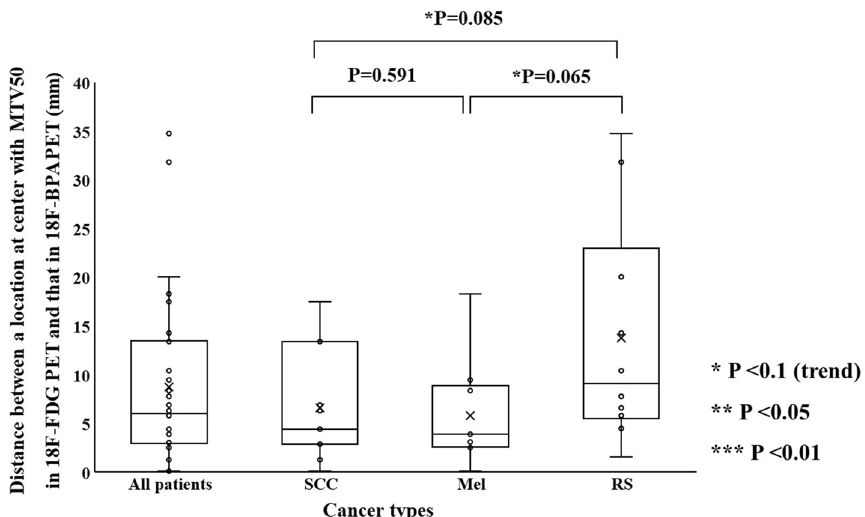
Fig. 9 The distances between locations at the center of mass with MTV50 between 18 F-FDG and 18 F-BPA PET for all patients, squamous cell carcinoma, melanoma, and rhabdomyosarcoma